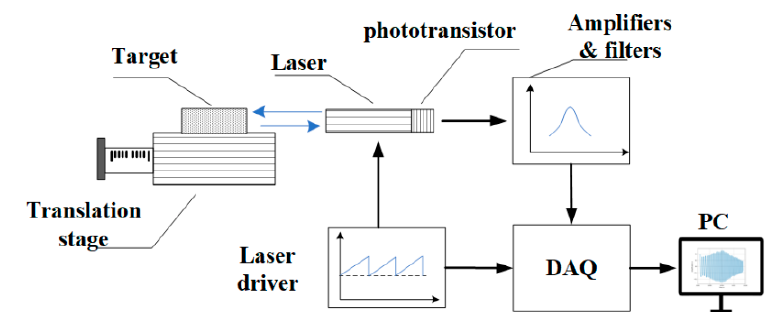
Figure 2. Schematic diagram of the experimental setup.